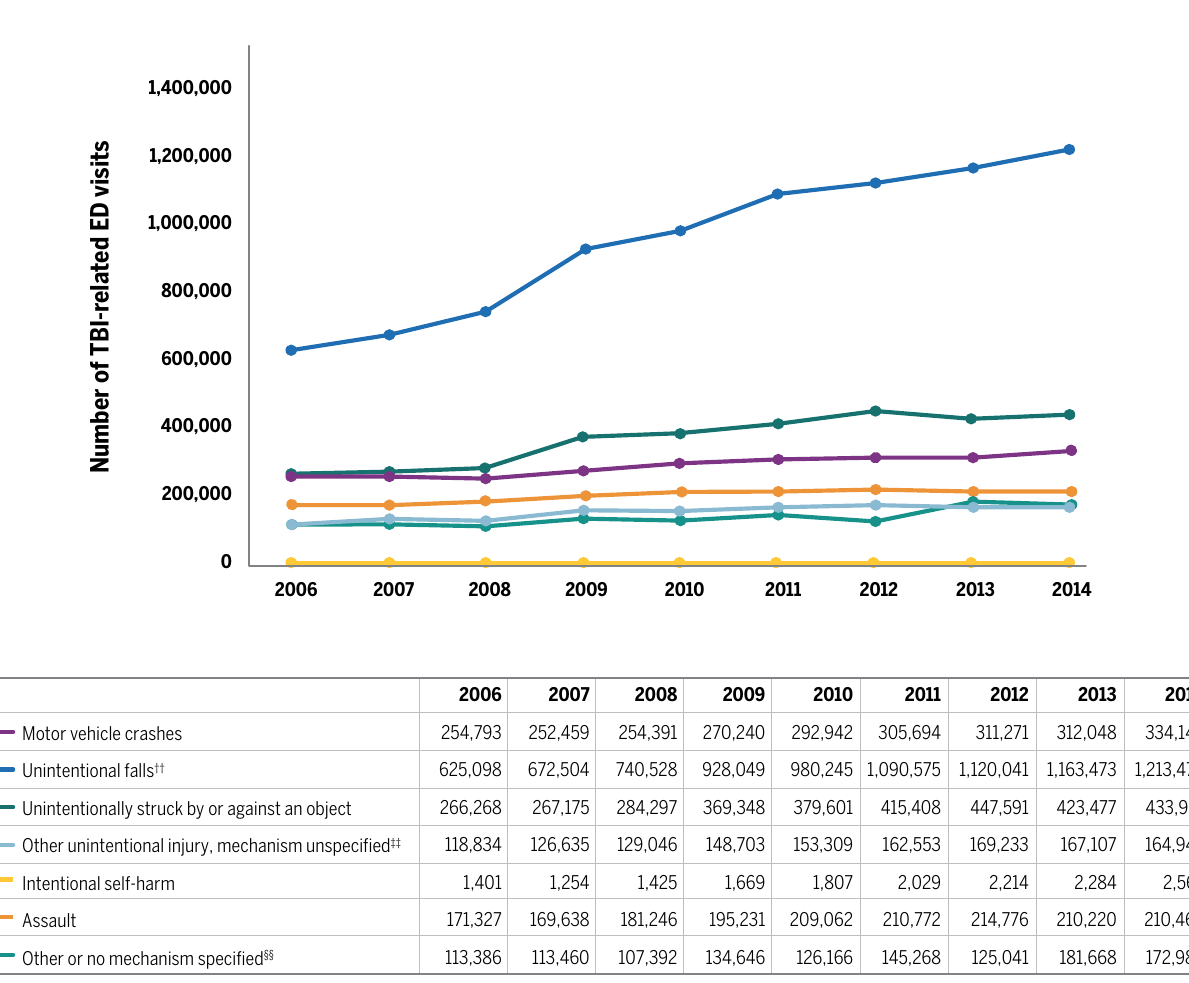
FIGURE 2B: ESTIMATED NUMBER OF TRAUMATIC BRAIN INJURY–RELATED EMERGENCY DEPARTMENT VISITS † , BY YEAR AND MECHANISM OF INJURY,